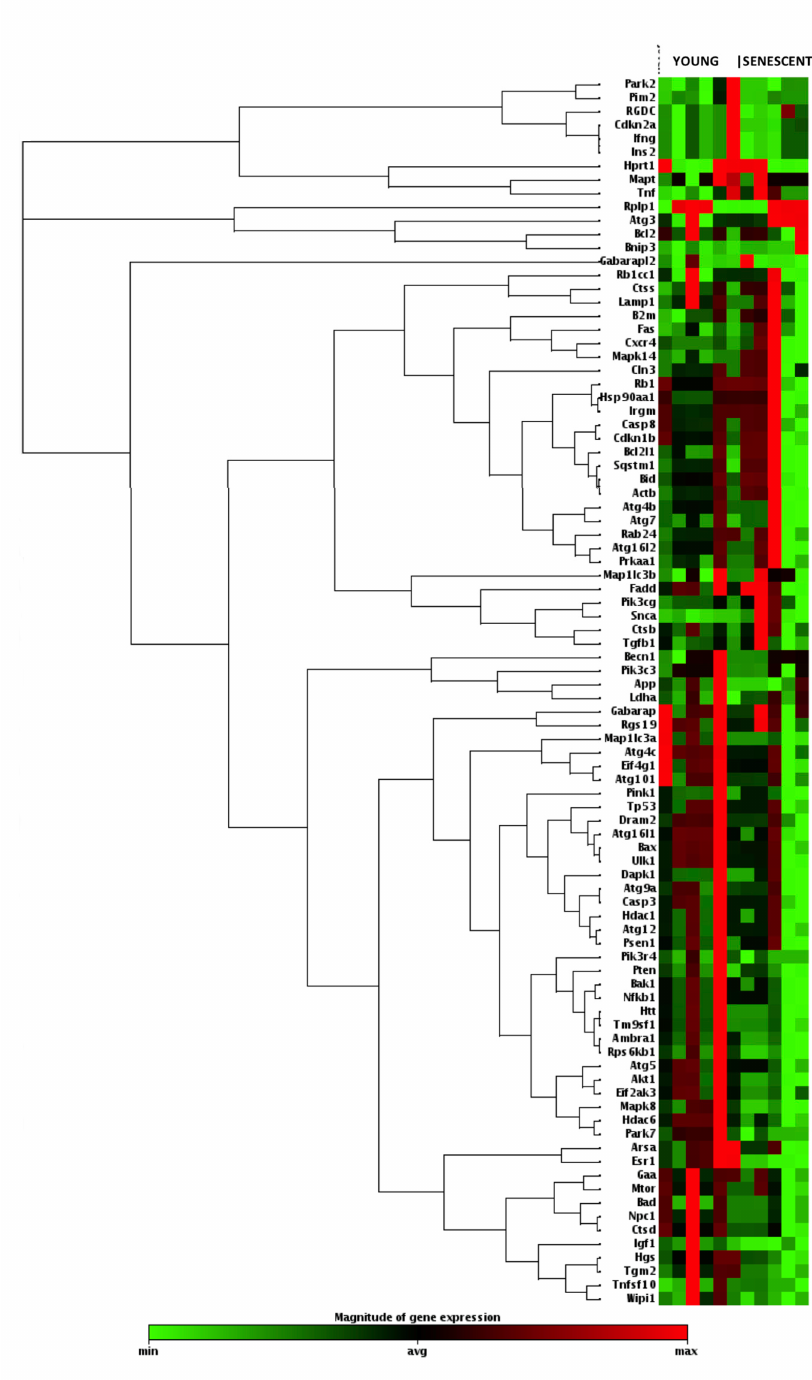
Figure 2. Heatmap of gene expressions and unsupervised hierarchical cluster analysis for genes of the autophagy pathway comparing young rats (3 weeks, N = 6) and senescent rats (25 months, N = 5). All data were normalized to the best housekeeping genes. Green = downregulated; red = upregulated. Magnitude of log2 (fold change): from − 1.84 to